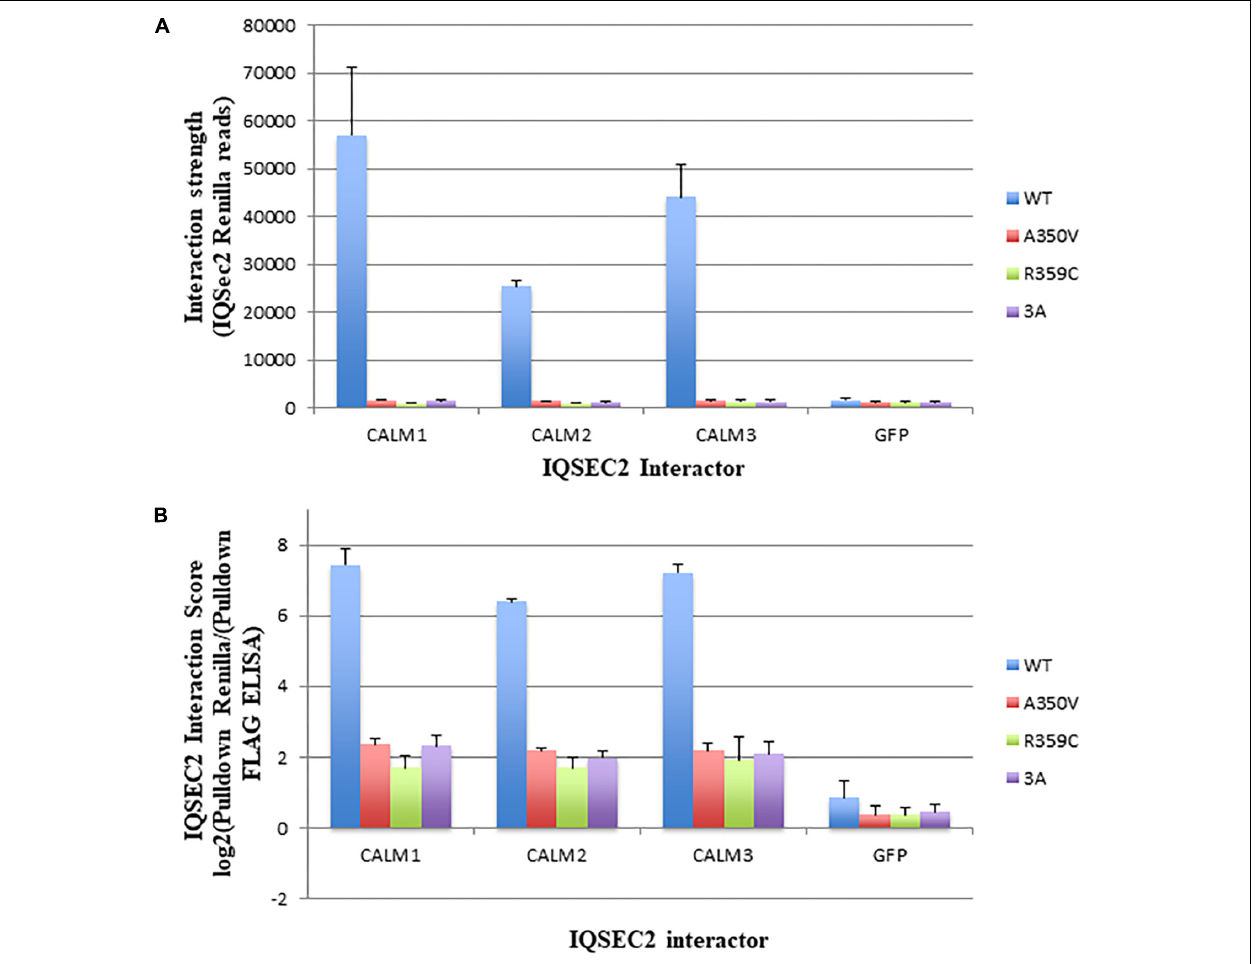
FIGURE 2 | Binding of wild type and mutant IQSEC2 to calmodulins in cells using the Lumier assay. (A) Interaction strength of wild type and mutant IQSEC2 proteins and calmodulins, measured as renilla luciferase-IQSEC2 activity after pulldown of calmodulin-FLAG proteins. Shown are mean and SD of 4 biological replicate wells for each pair of IQSEC2 calmodulin interactions. (B) Interaction score of wild type and mutant IQSEC2 proteins and calmodulins, measured as log2 of renilla luciferase-IQSEC2 activity after FLAG pulldown divided by pulldown FLAG ELISA, to normalize for the interactor levels. Shown are the mean and SD of 4 biological replicate wells for each pair of IQSEC2 calmodulin interactions. Data comparing A350V IQSEC2 and wild type IQSEC2 are representative of four independent experiments done on independent days and the data for the R359C and 3a mutants are representative of two independent experiments done on independent days.